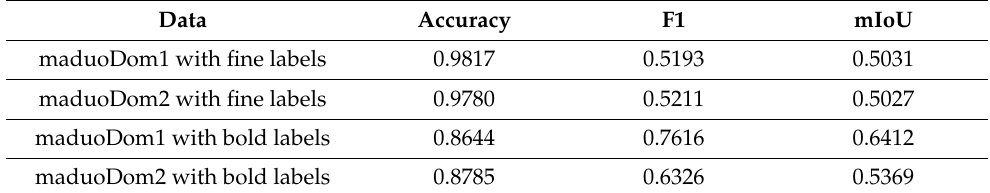
Table 2. Quantitative evaluation results of crack identification in the four datasets.